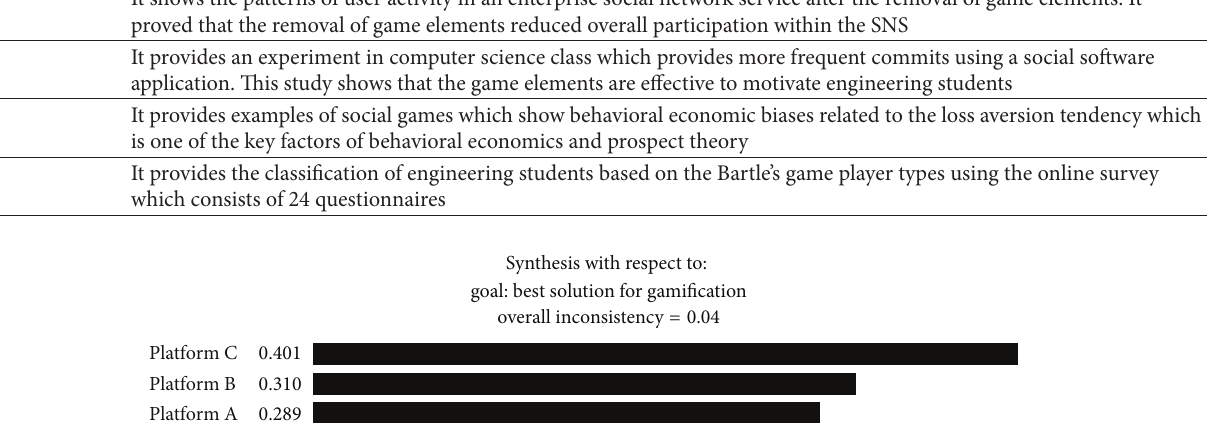
Figure 2: Synthesis result of the selection problem (exported from Expert Choice).